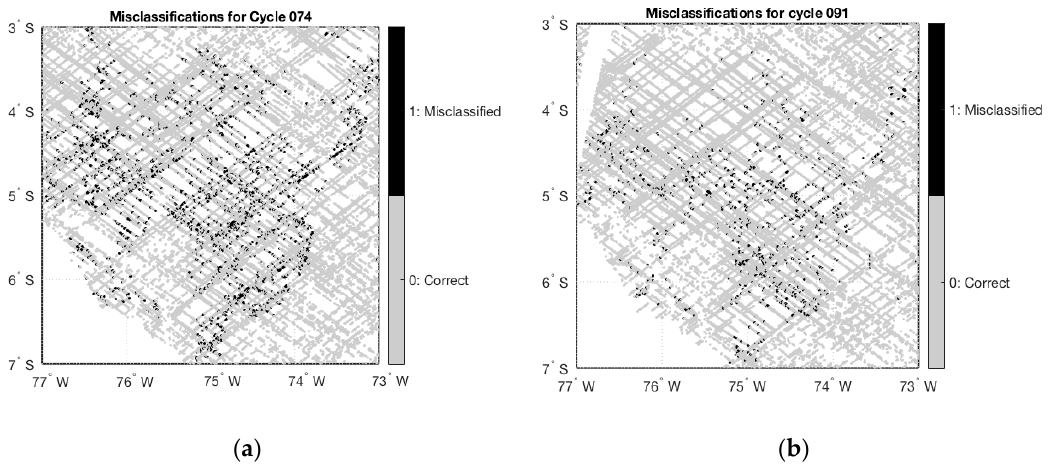
Figure 10. Location of the misclassifications observed for ( a ) cycle 074 and ( b ) cycle 091.